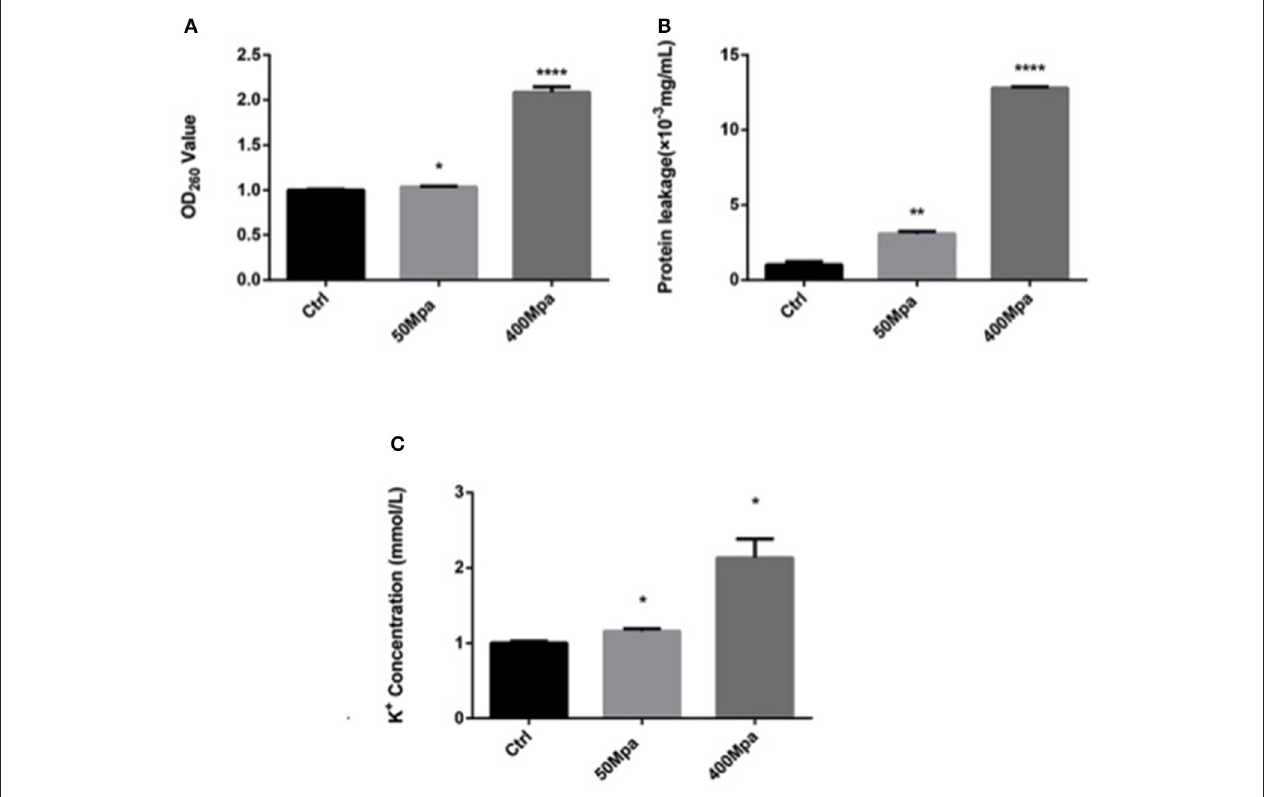
FIGURE 2 | Intracellular leakage after HHP treatment. (A) Nucleic acid leakage, (B) protein leakage, (C) potassium leakage. Asterisks indicate difference between control and different HHPs at * P < 0.05, ** P < 0.01, *** P < 0.001, and **** P <